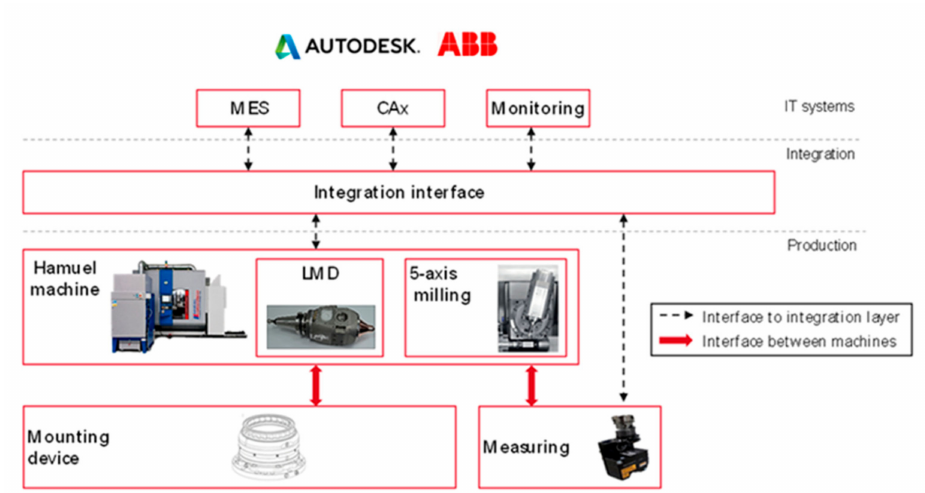
Figure 6. Layout of the LMD hybrid production cell.